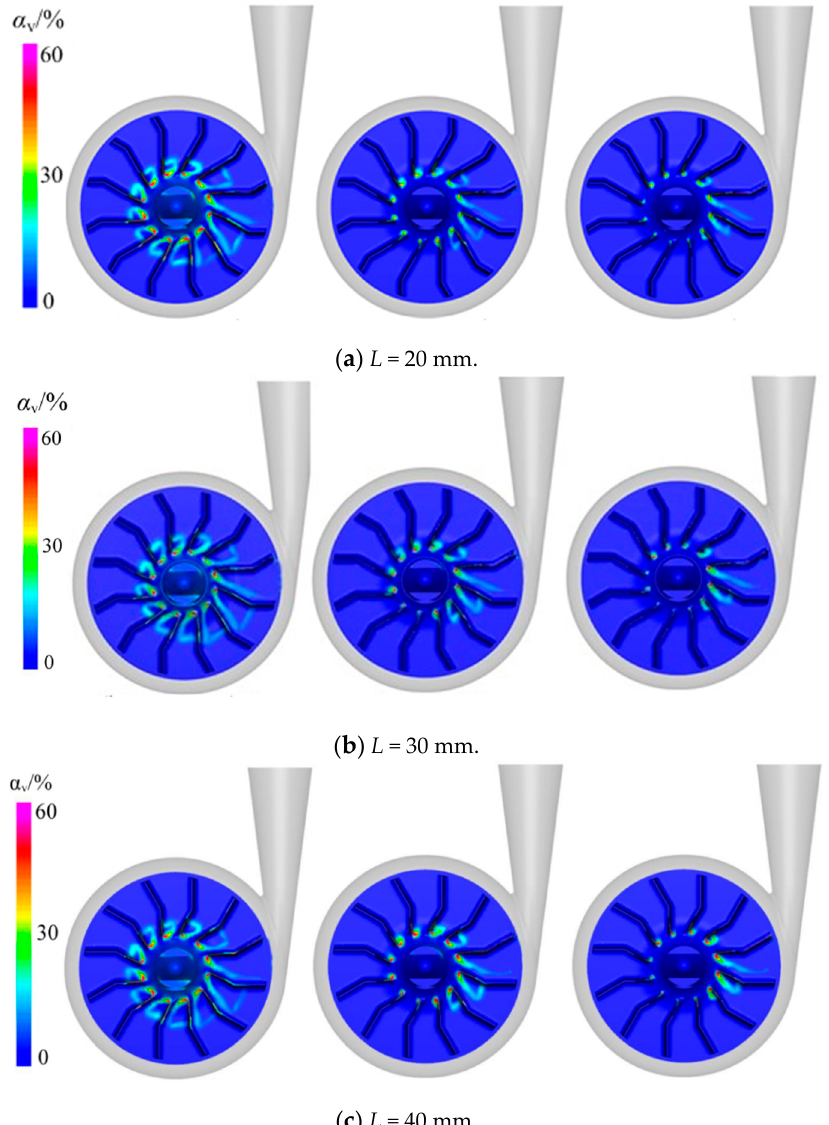
Figure 6. The internal flow field ( α v ) distribution of the pump with different L values under the three cases of inlet total pressure.